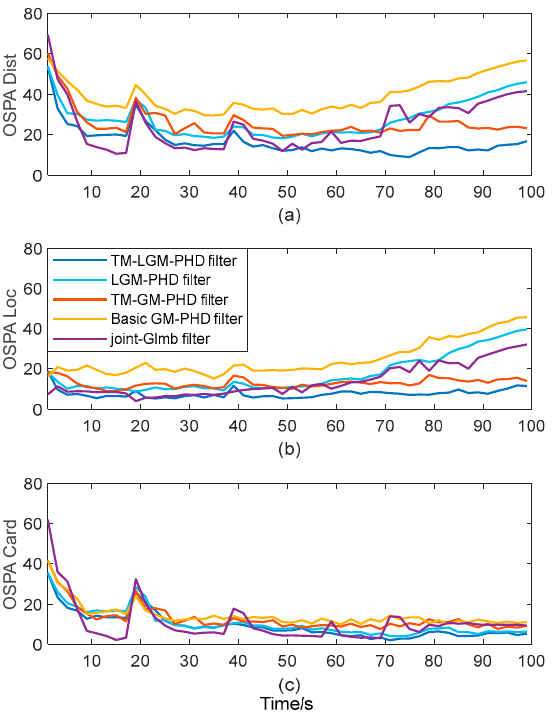
Figure 16. The average OSPA of different filters in example 2 (CA motion model) for 100 sample runs, when T s = 2 s ( T i = 4 ms, λ = 52, p D , k = 0.96). ( a ) Average OSPA distances of different filters. ( b ) OSPA locations of different filters. ( c ) OSPA cardinalities of different filters.